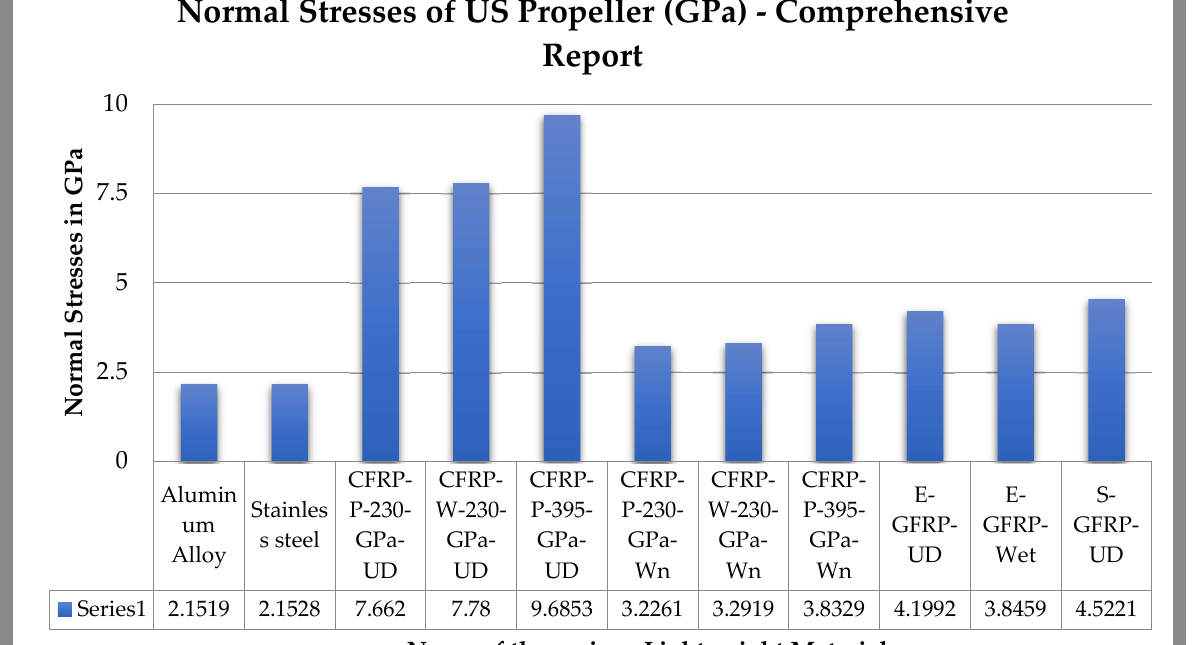
Figure 27. Comparative structural parameters 300 m with the speed of 20 m/s—Normal Stresses.